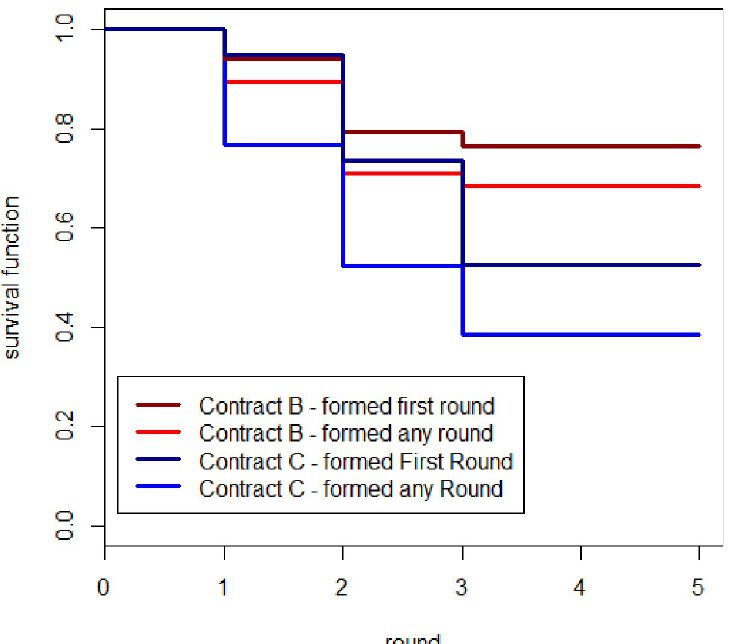
Fig 5. K-M survival curve across